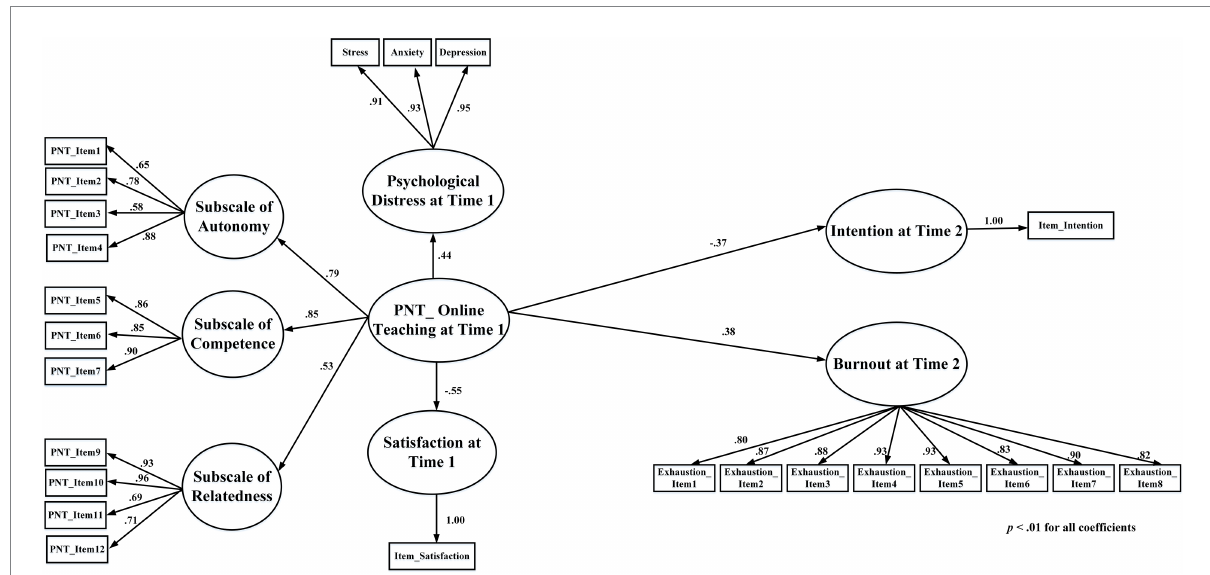
FIGURE 1 Criterion validity as examined by structural equation modeling (SEM; including second-order confirmatory factor analysis and a causal model; n = 1,642); variables include psychological need thwarting of online teaching (PNT_Online Teaching), satisfaction with online teaching (Satisfaction), and intention of continuing online teaching the future